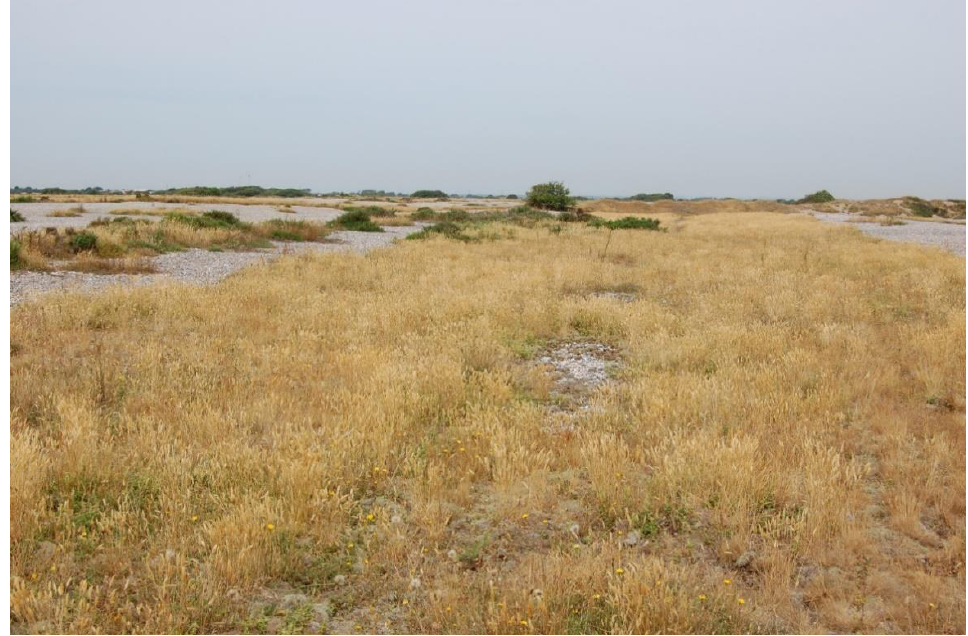
Figure 7. Vegetated shingle at Dungeness dominated by the grass Anthoxanthum odoratum . Dungeness is the only known site where Anoscopus duffieldi has been recorded. Photo taken by Alan Stewart. Further work could include sequencing of nuclear genes that are less conserved than